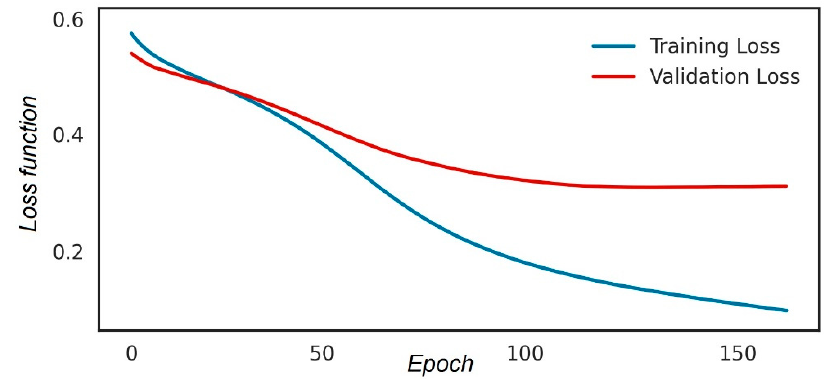
Figure 10. The estimated loss function for the SVM model.